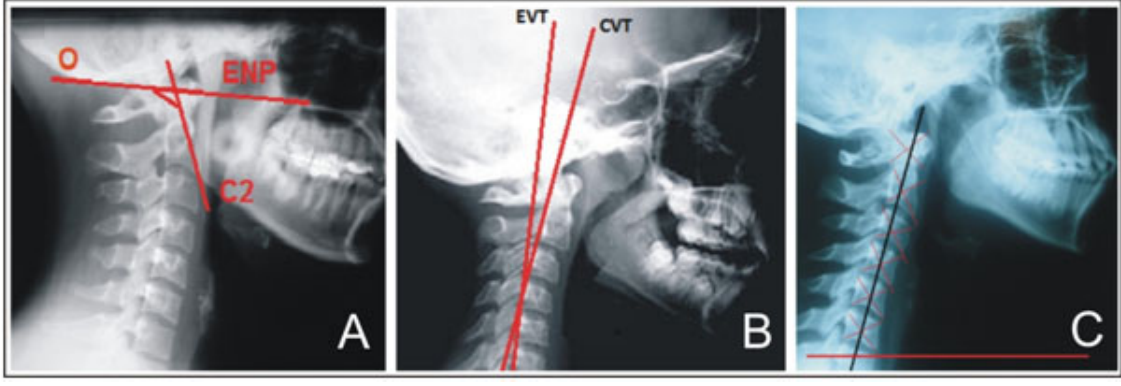
Fig. 2 – Craniocervical cephalometric variables . A) craniovertebral angle (CVT); B) CVT/EVT Angle – Cervical lordosis; C) CPL/HOR angle– Forward head posture.